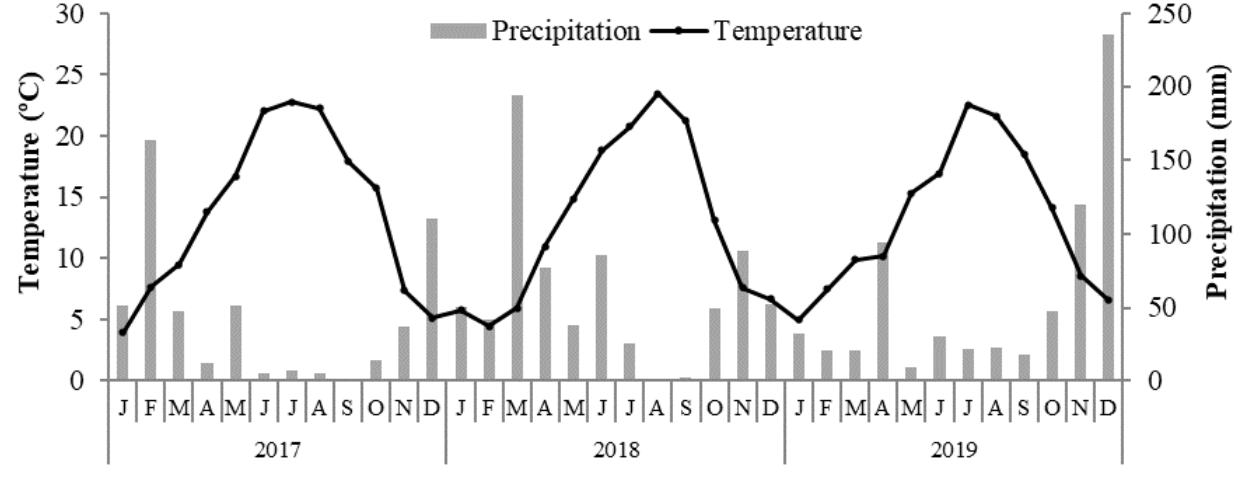
Figure 1. Average monthly temperature and precipitation during the experimental period (2017 –